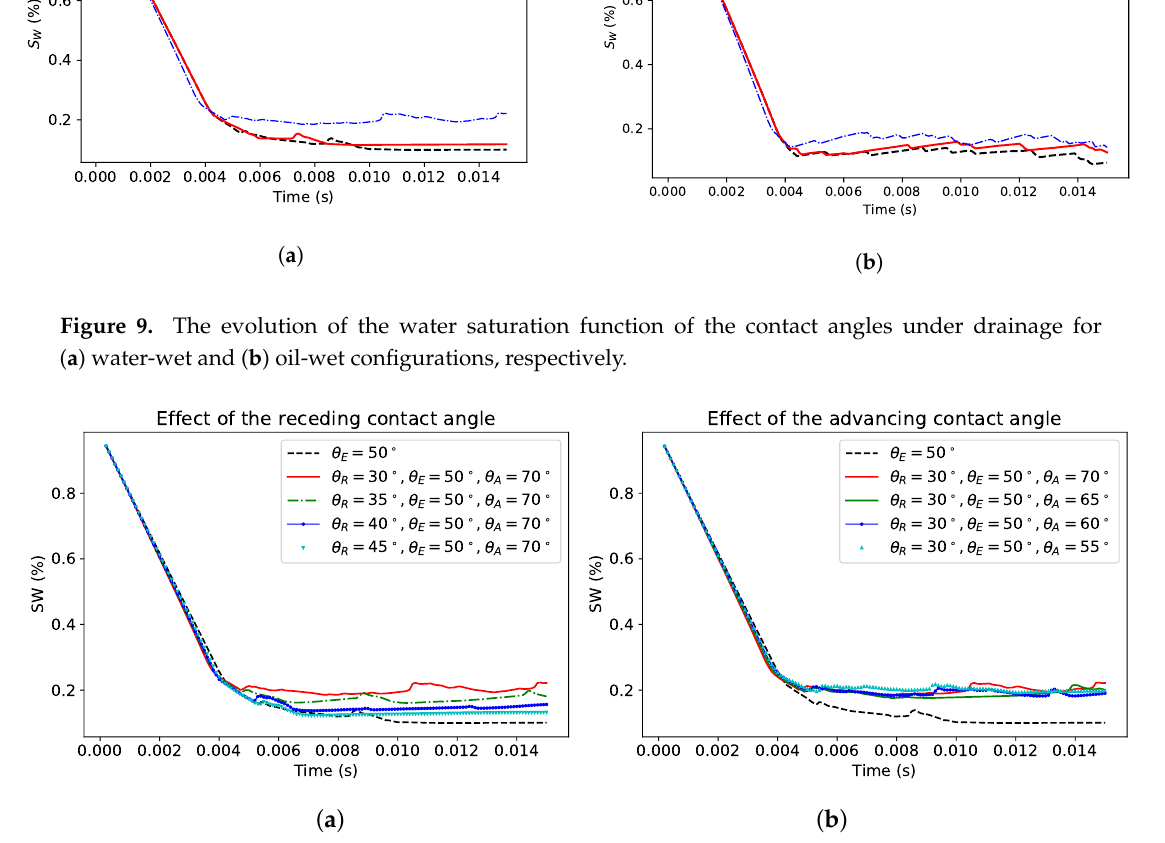
Figure 10. Sensitivity to the contact angles at the water-wet configuration for the receding ( a ) and advancing ( b ) contact